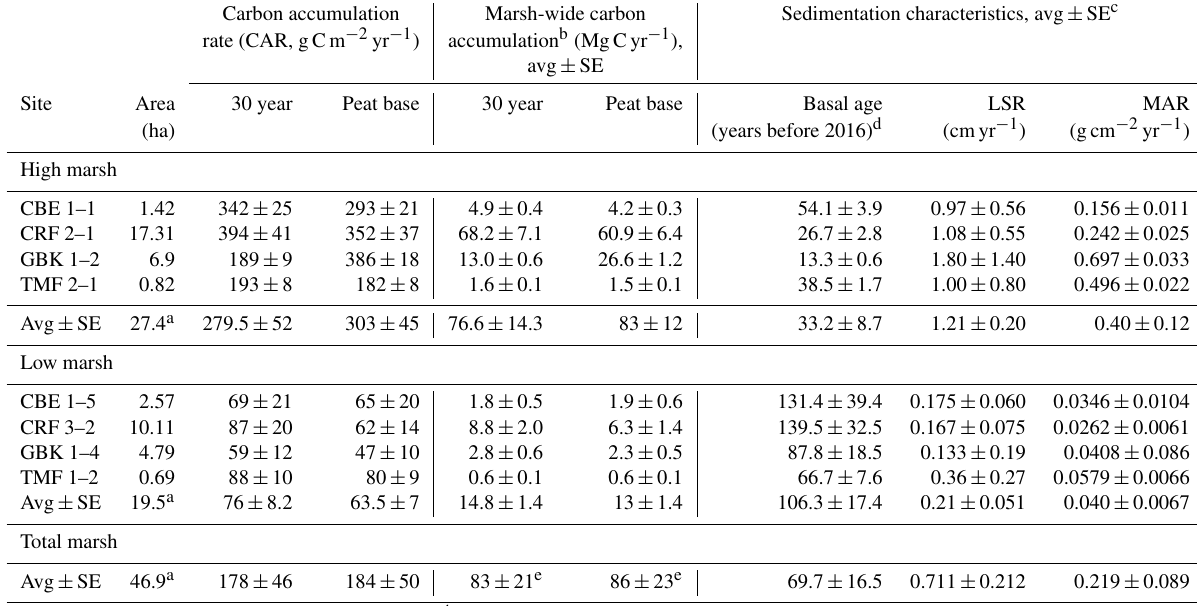
Table 2. Core and marsh-wide carbon accumulation rates. Carbon